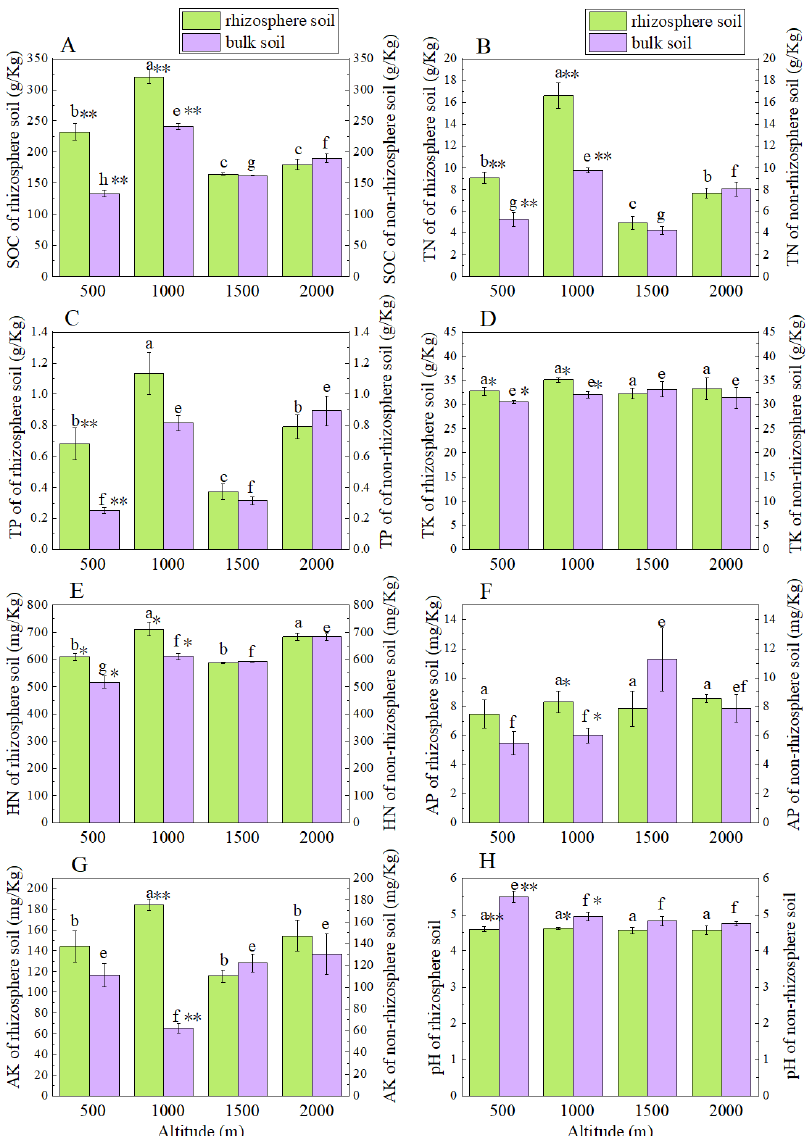
Figure 2. Nutrient contents and pH value in rhizosphere and bulk soils of Smilax china L. at different altitudes: ( A ), SOC of rhizosphere and bulk soils; ( B ), TN of of rhizosphere and bulk soils; ( C ), TP of rhizosphere and bulk soils; ( D ), TK of rhizosphere and bulk soils; ( E ), HN of rhizosphere and bulk soils; ( F ), AP of rhizosphere and bulk soils; ( G ), AK of rhizosphere and bulk soils; ( H ), pH of rhizosphere and bulk soils; different lowercase letters (a–c) indicate significant differences at p < 0.05 among rhizosphere soils at different altitudes; different lowercase letters (e–h) indicate significant differences at p < 0.05 among bulk soils at different altitudes; * and ** indicate significant differences between rhizosphere and bulk soils at the same altitude at p < 0.05, p < 0.01,